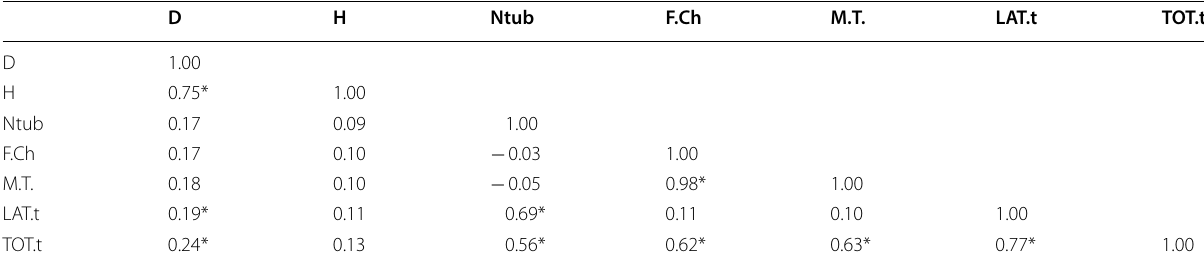
D, shell diameter; H, shell height; Ntub, number of spermathecal tubules; F.Ch., length of the fertilization chamber; M.T., length of the main tubule; LAT.t, the cumulative length of lateral tubules; TOT.t, the cumulative length of all tubules Marked correlations (*) are significant at p < 0.05